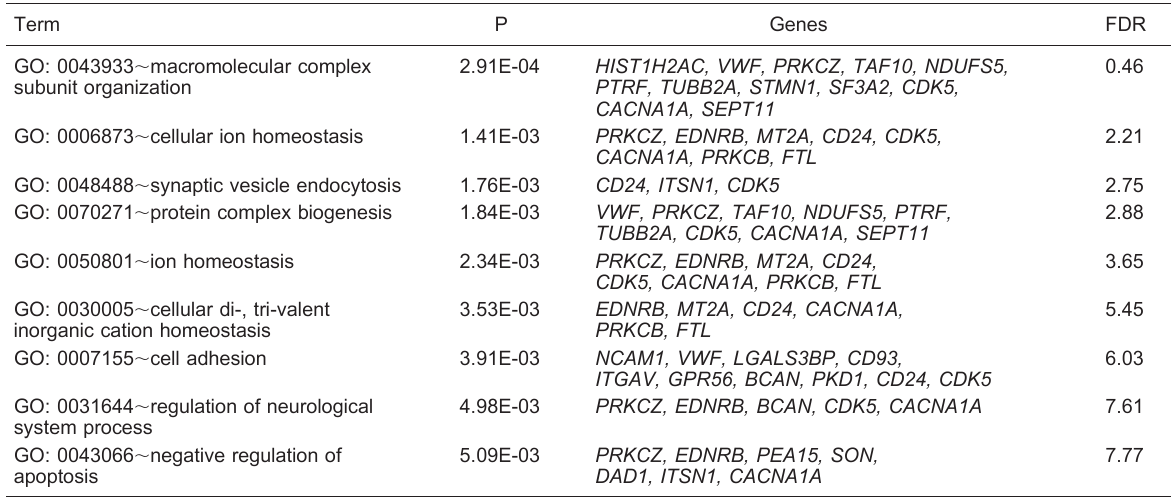
Table 2. Gene ontology (GO) functional annotation of 73 differentially expressed genes. Term